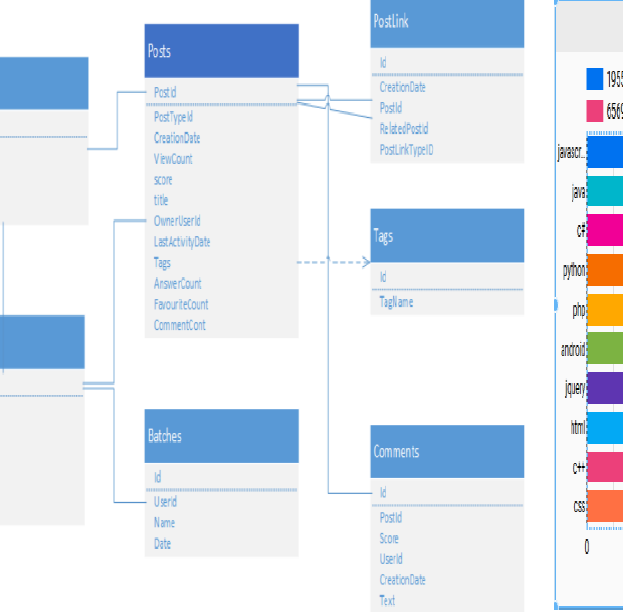
Figure 2. Stacked bar chart for top 10 Tags time between (2008 and 2019).